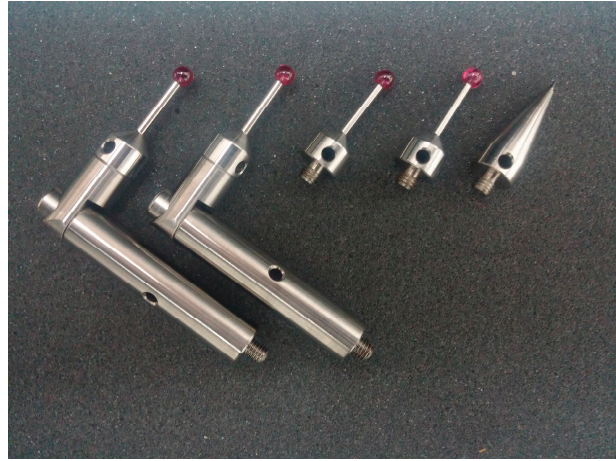
Figure 1. The LPCMM system. 1 (cid:13) Laptop computer, 2 (cid:13) camera, 3 (cid:13) light-pen, 4 (cid:13) workpiece. Figure 1. The LPCMM system. ① Laptop computer, ② camera, ③ light-pen, ④ workpiece. Figure 1. The LPCMM system. ① Laptop computer, ② camera, ③ light-pen, ④ workpiece.